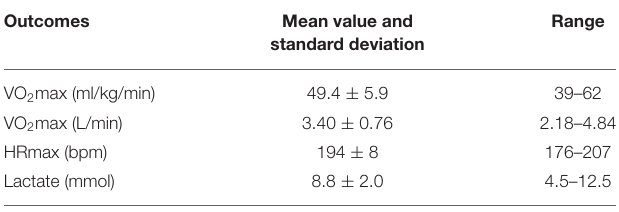
TABLE 1 | Participants’ characteristics. TABLE 2 | Peak responses to the graded treadmill exercise test.